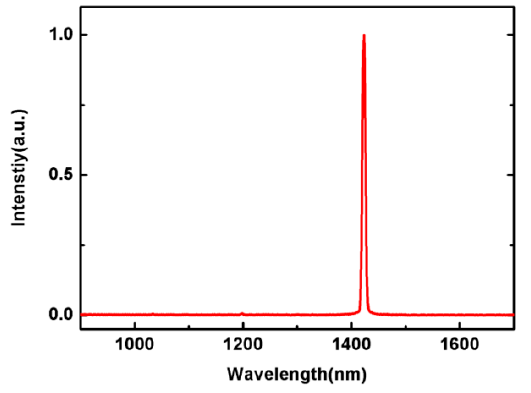
Figure 6. Spectrum of the diamond Raman laser at the 2nd Stokes wavelength of 1420 nm.